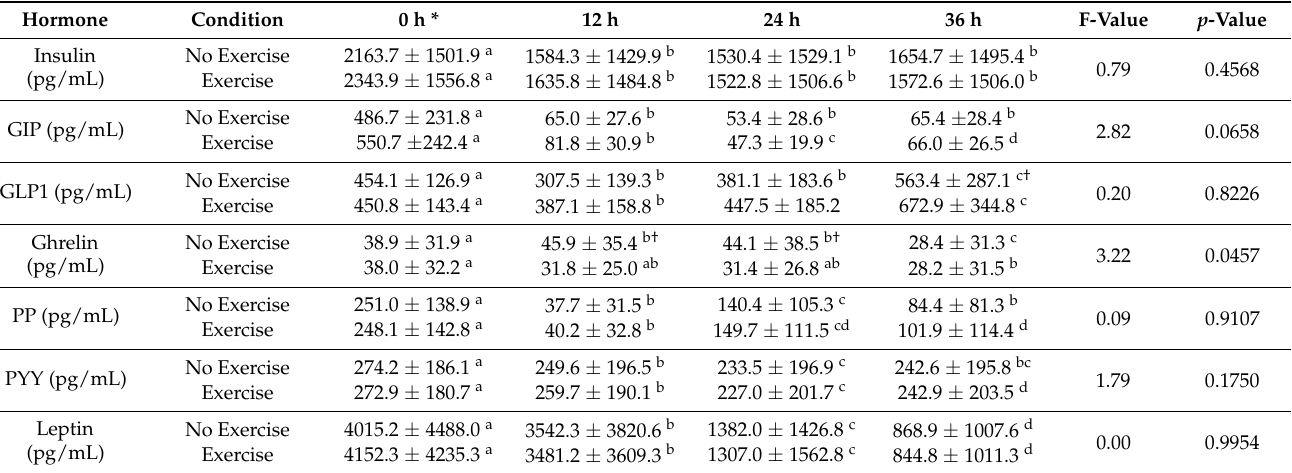
Table 2. Hormone concentrations (pg/mL) at four time points during a 36 h fast with or without